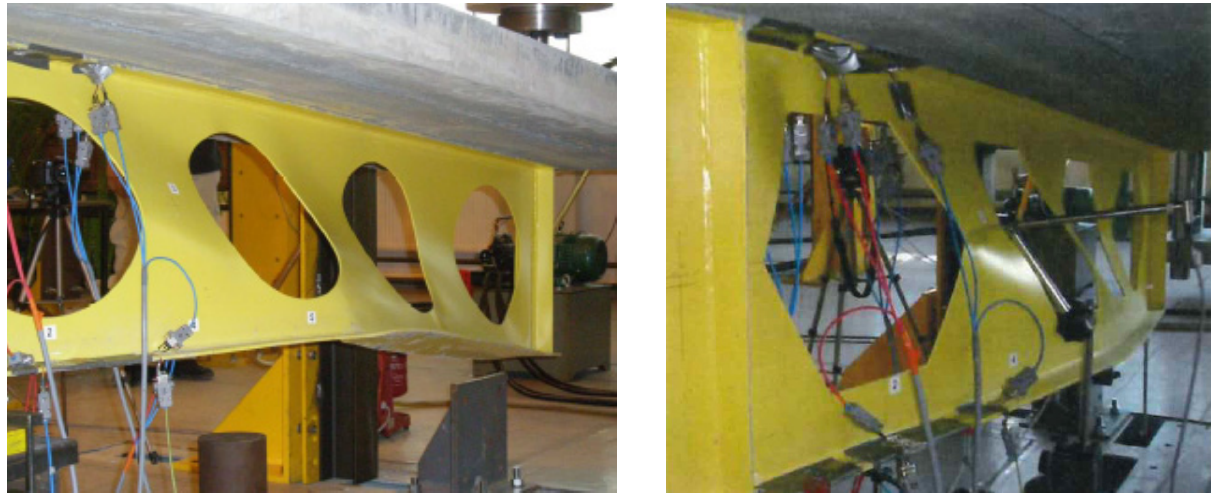
Figure 6. Lateral distortional buckling in steel-concrete composite alveolar beams [58].